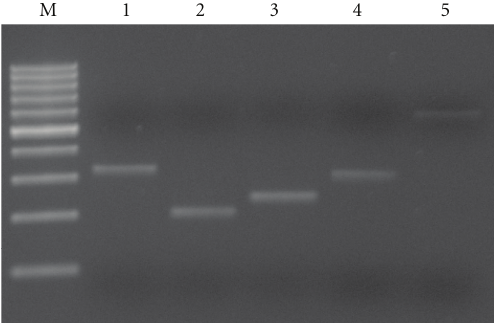
Figure 4: The gel showing the 5 exons of KISS1R